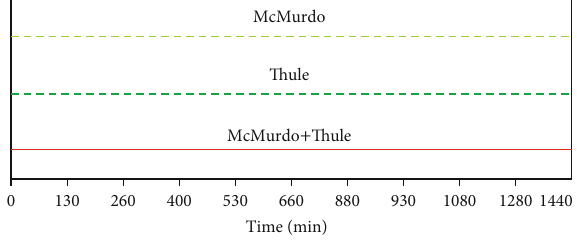
Figure 18: Sample 1: the amount of communications in one day for 6 COF satellites.